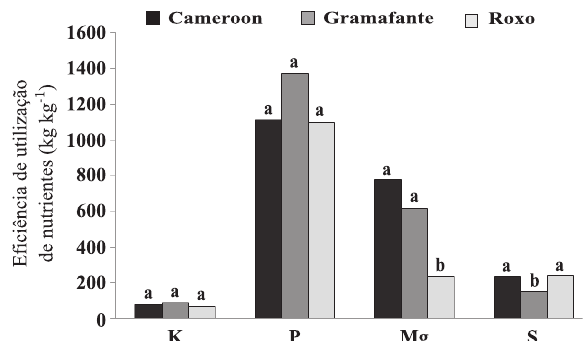
figura 5. Eficiência de utilização de potássio, fós- foro, magnésio e enxofre por três variedades de capim-elefante aos 213 dias após o plantio. letras minúsculas comparam as variedades para cada nutriente. letras minúsculas iguais não diferem (tukey, p ≤